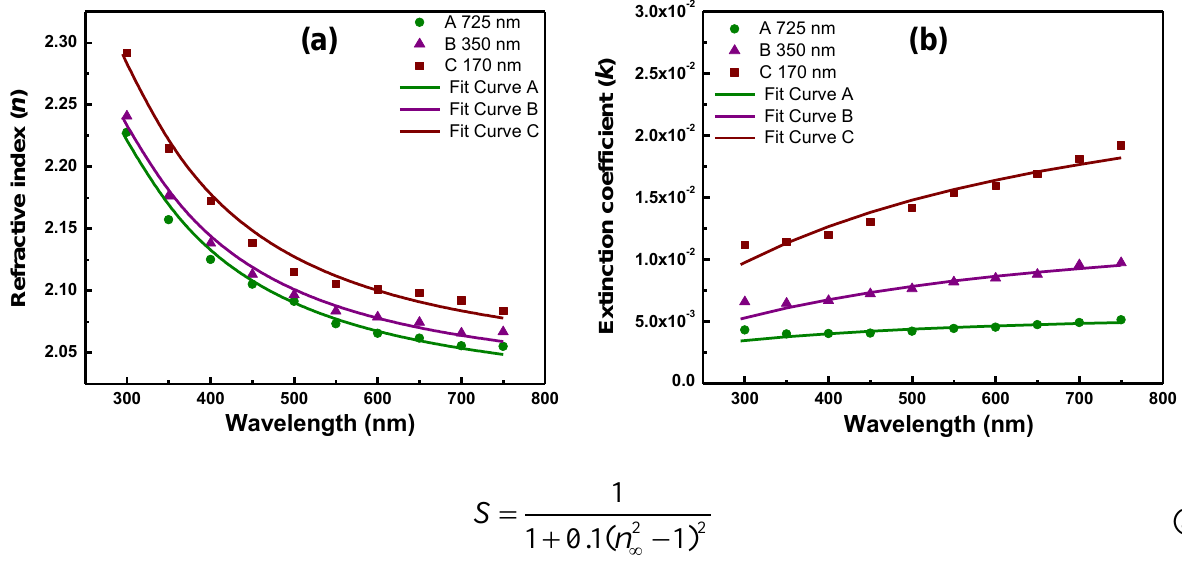
Figure 10. The refractive index spectral density ( a , b ) of the LaGdO using the envelope method. Cauchy’s polynomials fit well in the 300–750 nm range, indicative of the applicability of the Cauchy–Urbach model. Reproduced by permission of ECS–The Electrochemical Society